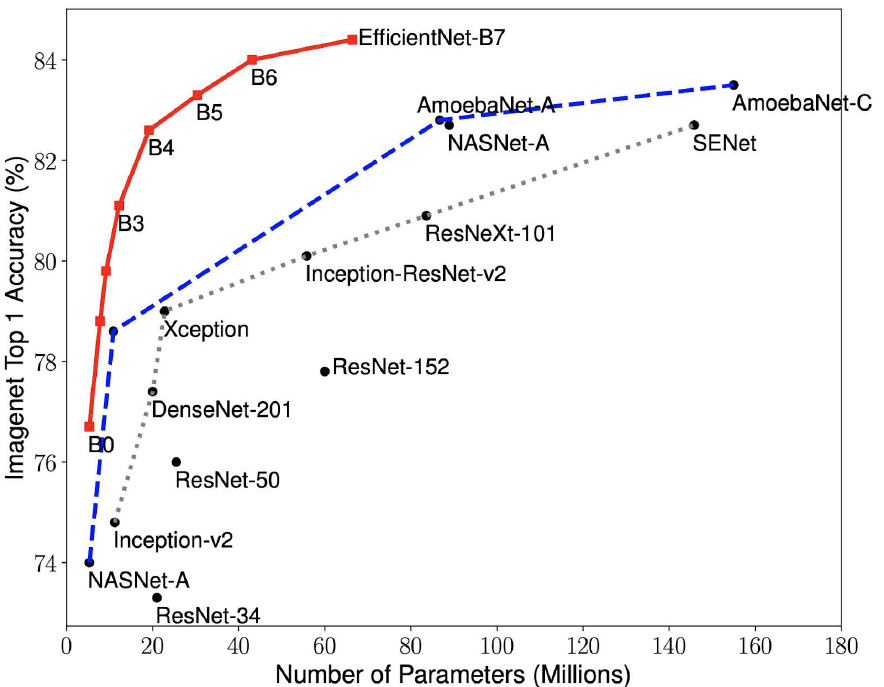
Figure 4. Model Size vs. Accuracy Comparison. EfficientNet-B0 is the baseline network, while Efficient-B1 to B7 are obtained by scaling up the baseline network.